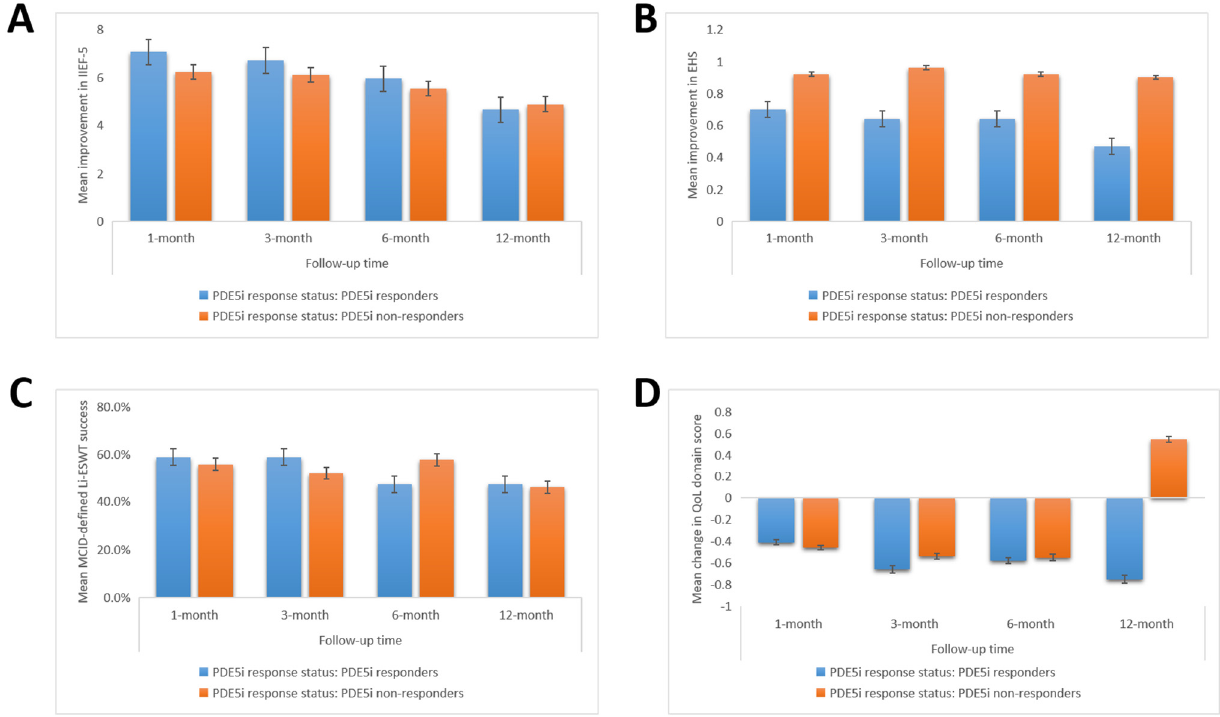
Figure 2. The therapeutic efficacy of Li-ESWT in patients stratified by PDE5i response. Histograms showing the ( A ) mean improvement in IIEF-5, ( B ) mean improvement in EHS, ( C ) mean MCID-defined Li-ESWT success, and ( D ) mean change in QoL domain score in patients with mild, mild-to-moderate, moderate, or severe ED, at indicated time-points. Li-ESWT, low-intensity extracorporeal shockwave therapy; ED, erectile dysfunction; IIEF-5, five-item International Index for Erectile Function; EHS, Erection Hardness Score; MCID, minimal clinically important difference; QoL, quality of life. Table 3. Negative predictors of Li-ESWT efficacy in our Taiwanese cohort (n =